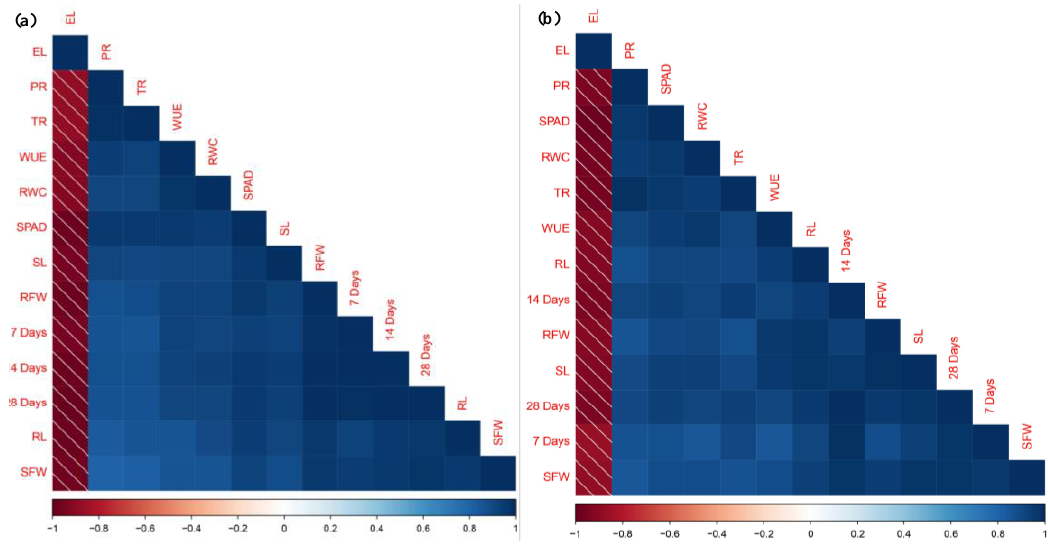
Figure 2. Pearson’s correlation matrix heat map shows correlations among different parameters in axenic experiments with ( a ) 100 and ( b ) 200 mg/kg glyphosate. 7 days = degradation of glyphosate at 7 days, 14 days = degradation of glyphosate at 14 days, 28 days = degradation of glyphosate at 28 days, SL = shoot length, RL = root length, SFW = shoot fresh weight, RFW = root fresh weight, PR = photosynthetic rate, EVT = transpiration rate, WUE = water use efficiency, RWC = relative water content, EL = electrolyte leakage, SPAD = chlorophyll SPAD value.